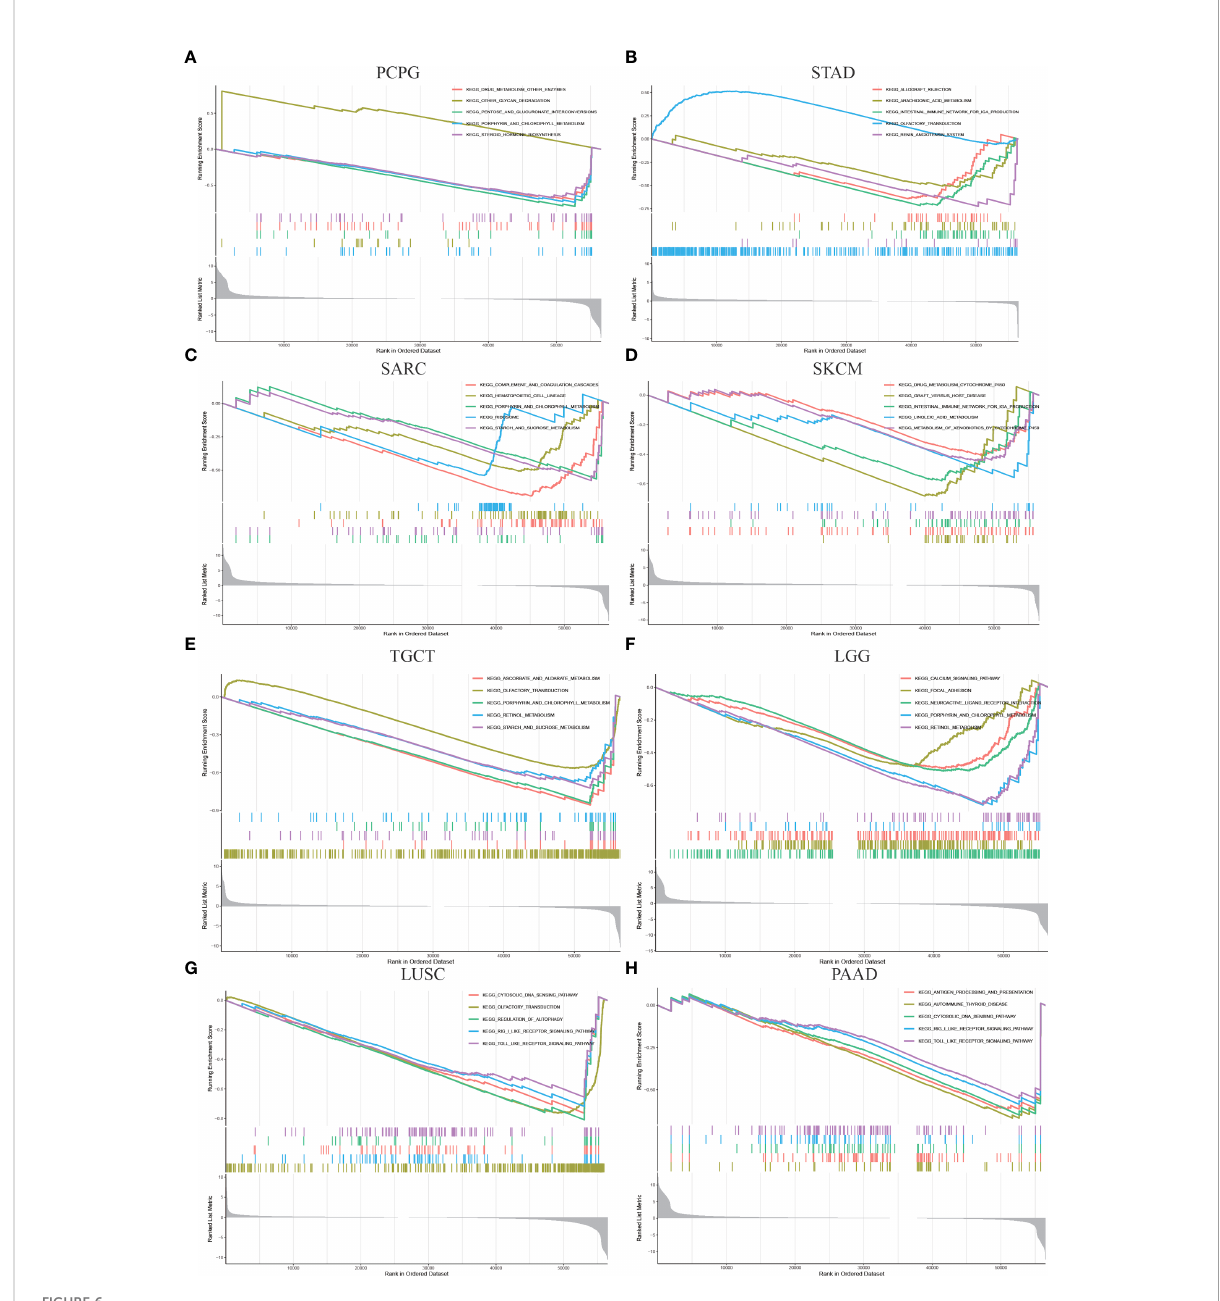
FIGURE 6 Gene enrichment analysis of OTUD6B in the KEGG database in PCPG, STAD, SARC, SKCM, TGCT, LUSC, LGG, and